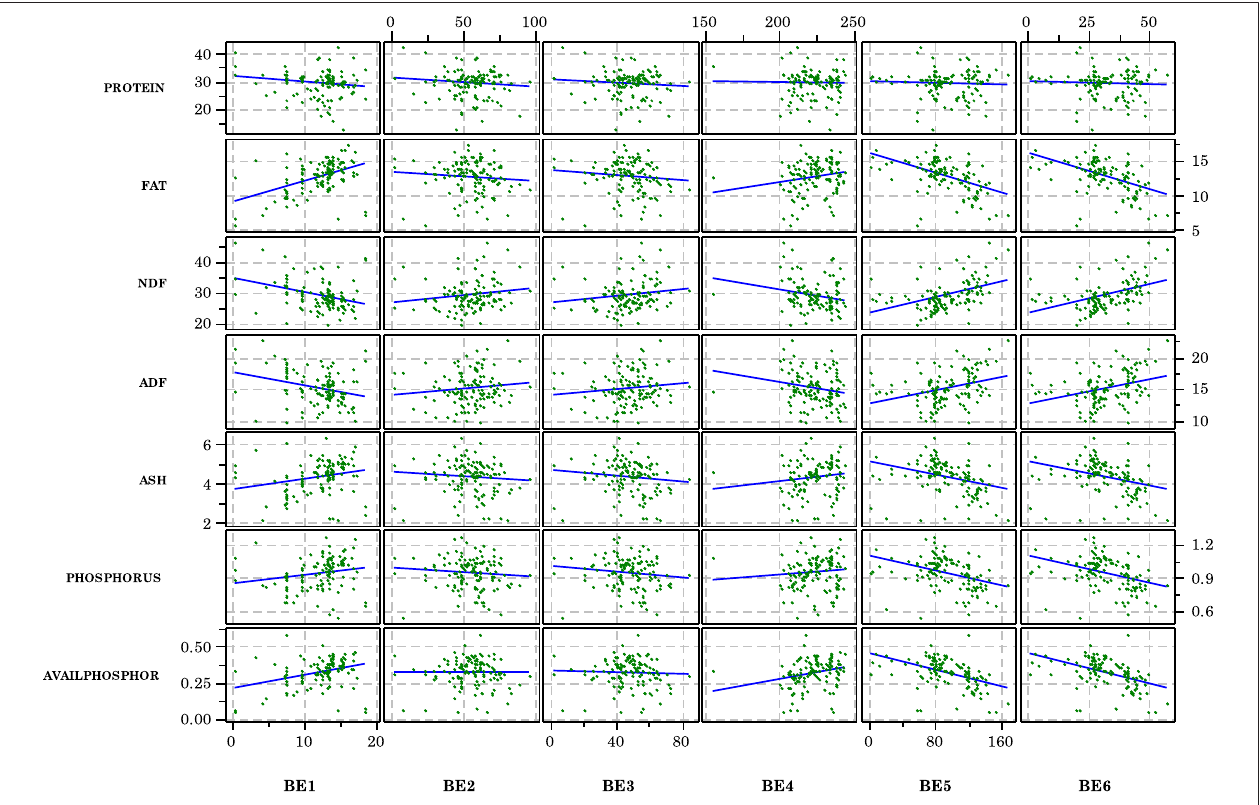
FIGURE 2 | Scatterplots of compositional variables for each back end independent variable. Although considerable scatter is present, some linear trends appear pronounced. Variable de fi nitions provided in Tables 1, 2 .